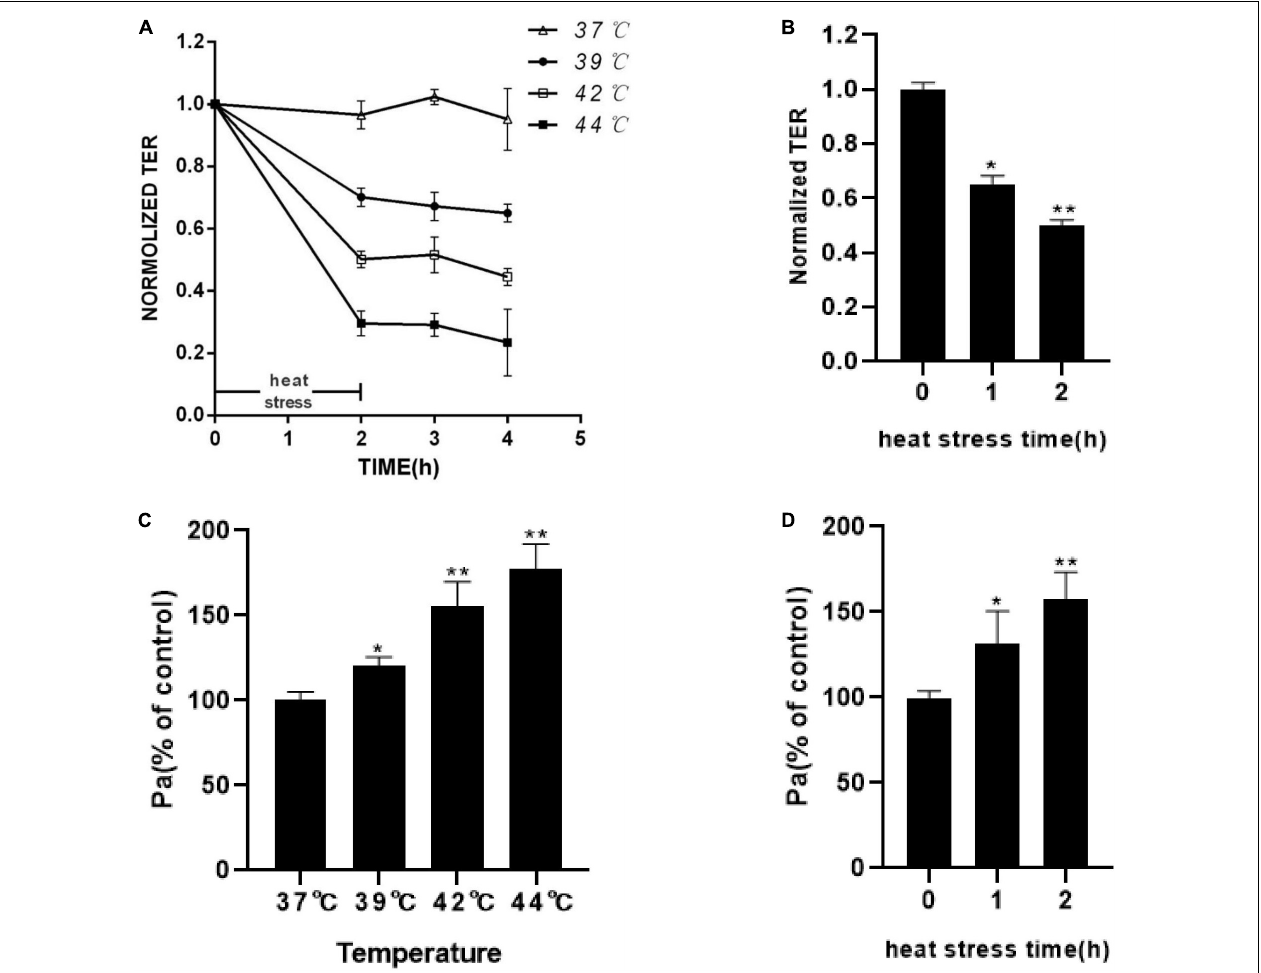
FIGURE 2 | Effect of increasing temperature or increasing heat stress time on HUVEC monolayer barrier function. (A) Increasing temperature decreased TEER. HUVEC monolayers were exposed to an increasing temperature for 2 h from 37 to 44 ◦ C. TEER was recorded before (used as a baseline) and after heat stress and presented relative (%TEER) to baseline. (B) Increasing heat stress time decreased TEER. HUVEC monolayers were exposed to 42 ◦ C for an increasing time from 1 to 2 h. TEER was measured before (used as a baseline) and 2 h after heat stress and presented relative (%TEER) to baseline. (C) Higher temperatures increased FITC-dextran flux. The amount of dextran flux was measured 2 h after heat stress and expressed as a percentage of control. (D) Increasing heat stress time increased FITC-dextran flux (* P < 0.05, ** P < 0.01 vs control